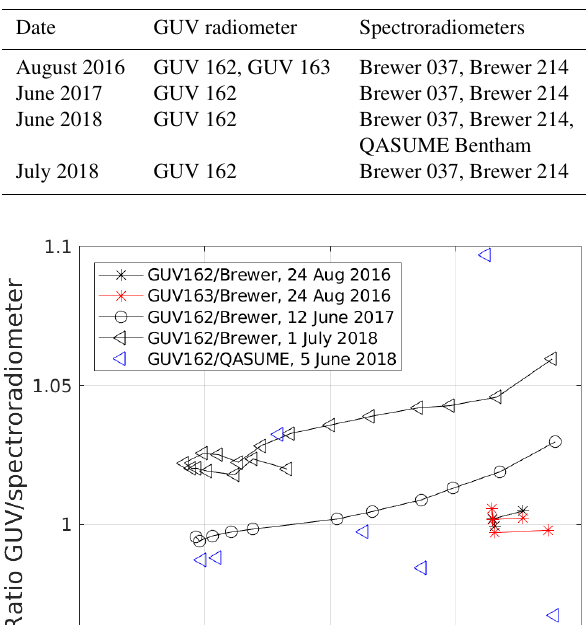
Table 3. Solar comparisons at Sodankylä, Finland.